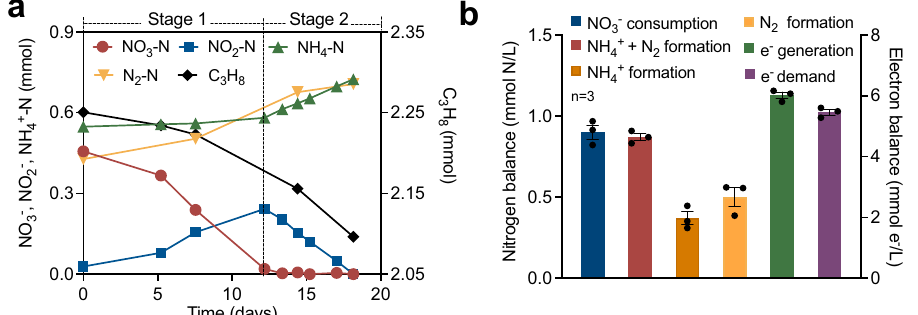
Fig. 2 | Mass balance and electron balance batch tests. a Typical biochemical pro fi le of the systems (started on Day 1050) showing simultaneous nitrate and propane consumption with transitory formation of nitrite, and production of dinitrogengasandammonium.Nitratereductionappearedtooccurintwodistinct phases. In Stage 1, nitrate was converted to nitrite and dinitrogen gas with